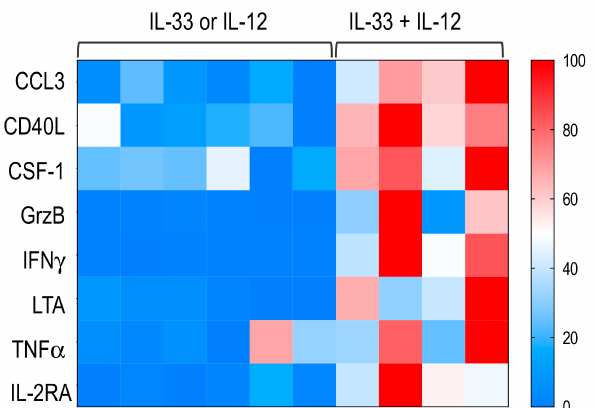
Figure 7. Sorted MAIT cells upregulated several pro-inflammatory factors following IL-33 + IL-12 stimulation. Heatmap showing a selection of significant mRNA expression enriched in sorted MAIT cells stimulated for 18 h with IL-33 + IL-12 compared to IL-33 or IL-12. Details are presented at Table